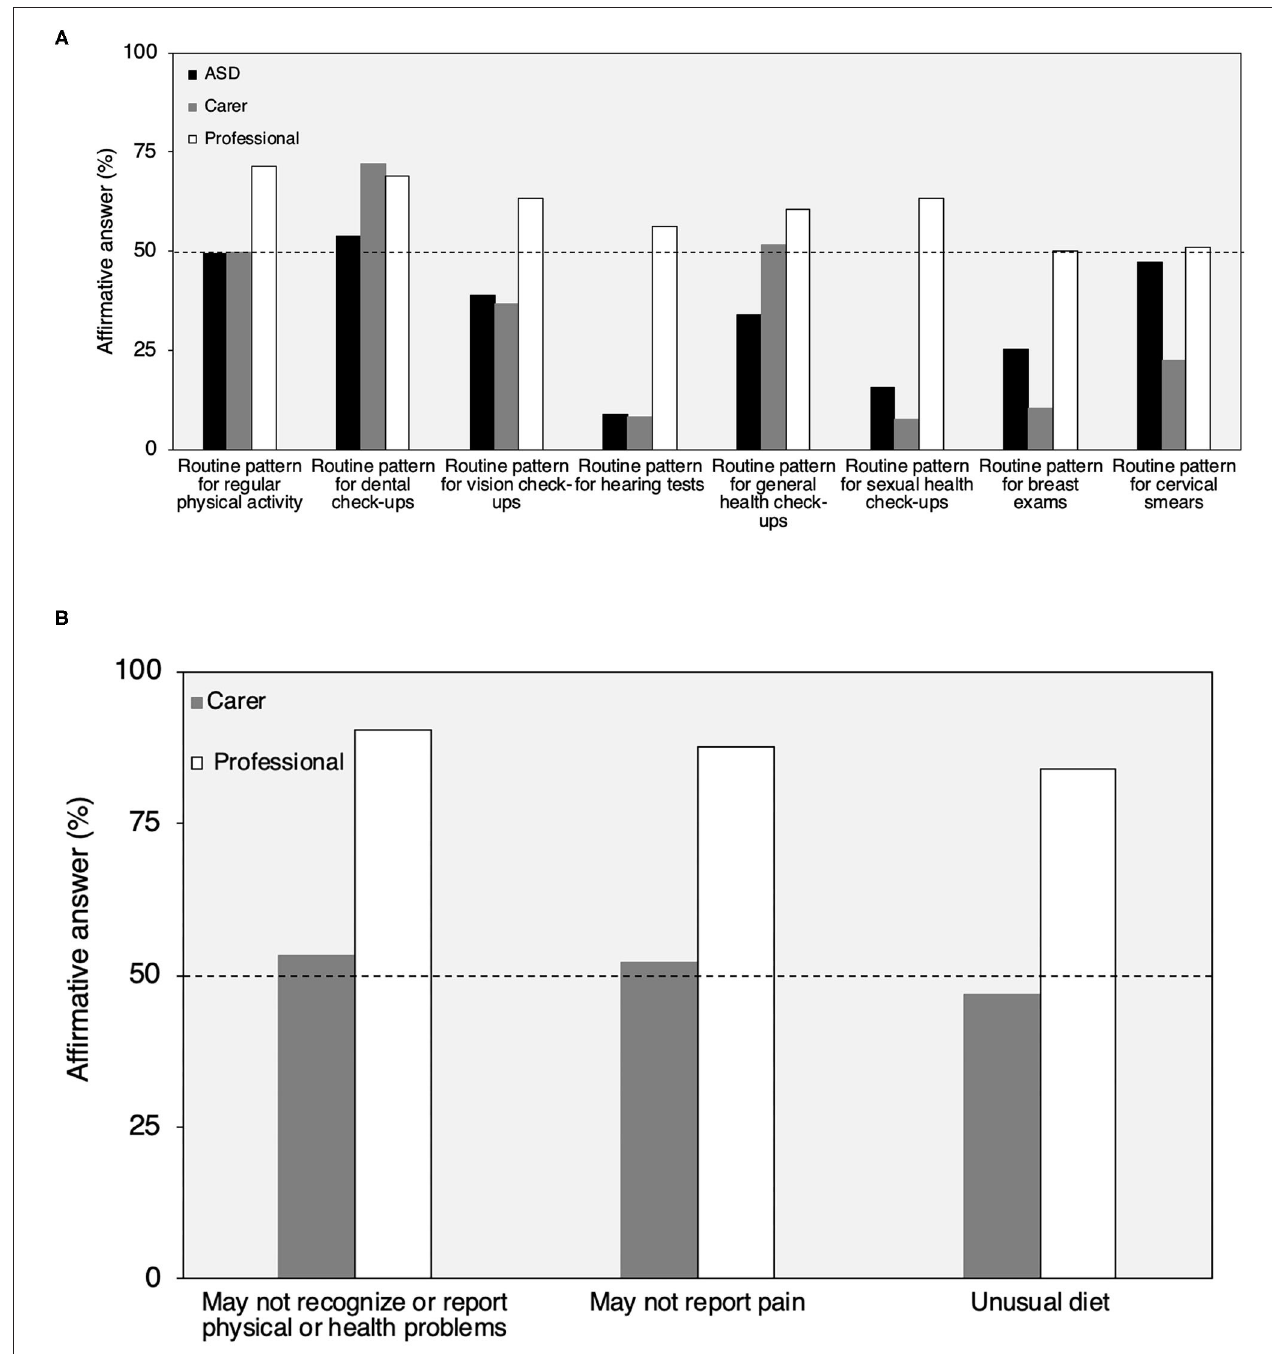
FIGURE 5 | Health behavior profile reported by autistic adults, carers, and professionals (A , B). Routine pattern for breast exams and cervical smears were collected only from autistic adult females (self-reported answers or reported by carers). N autistic adults: 515 to 342; N carers: 124 to 437; N professionals: 112 (A) . N carers: 437; N professionals: 113 (B) . In (A) , professionals answered YES if they believed the characteristic was LESS frequent in autistic than non-autistic adults. In (B) , they answered YES if they believed that the characteristic was MORE frequent in autistic than non-autistic